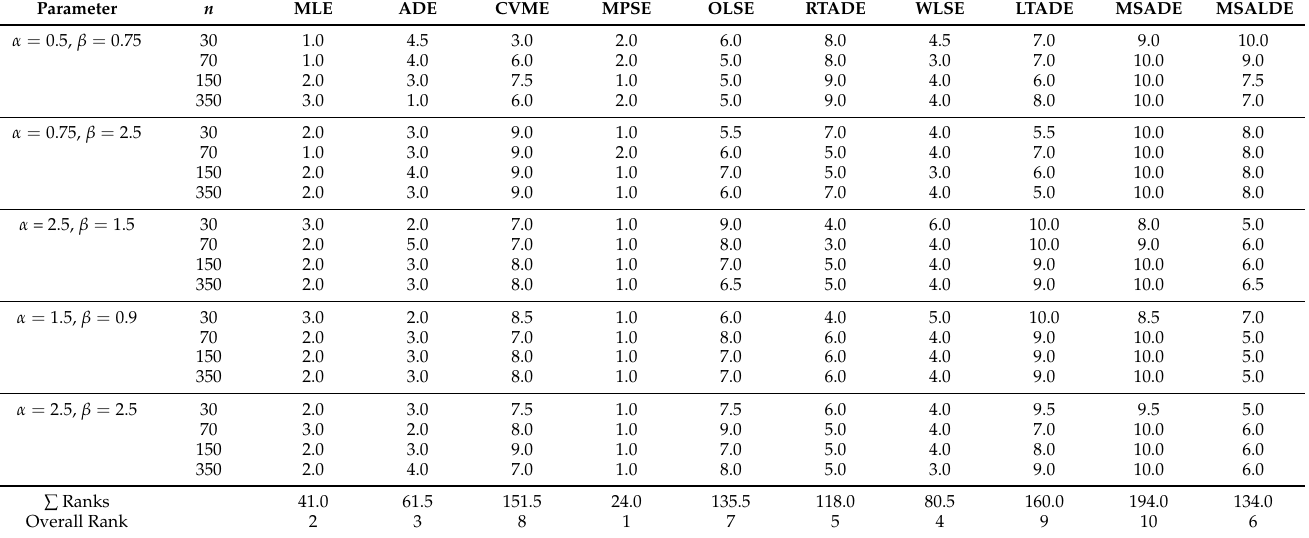
Table 6. Partial and overall ranks of the techniques for estimation of the PHD using various values of α and β